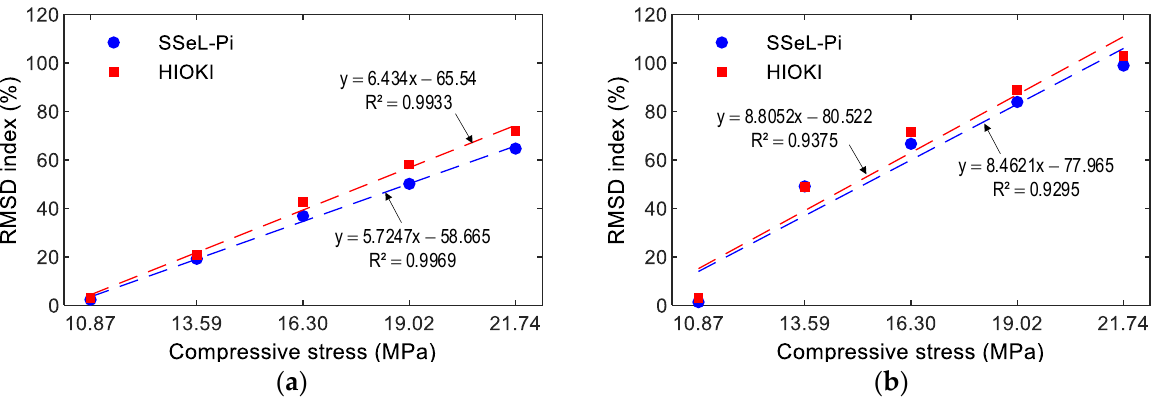
Figure 26. Relationship between RMSD index and corresponding compressive stress. ( a ) PZT1, ( b ) PZT2.